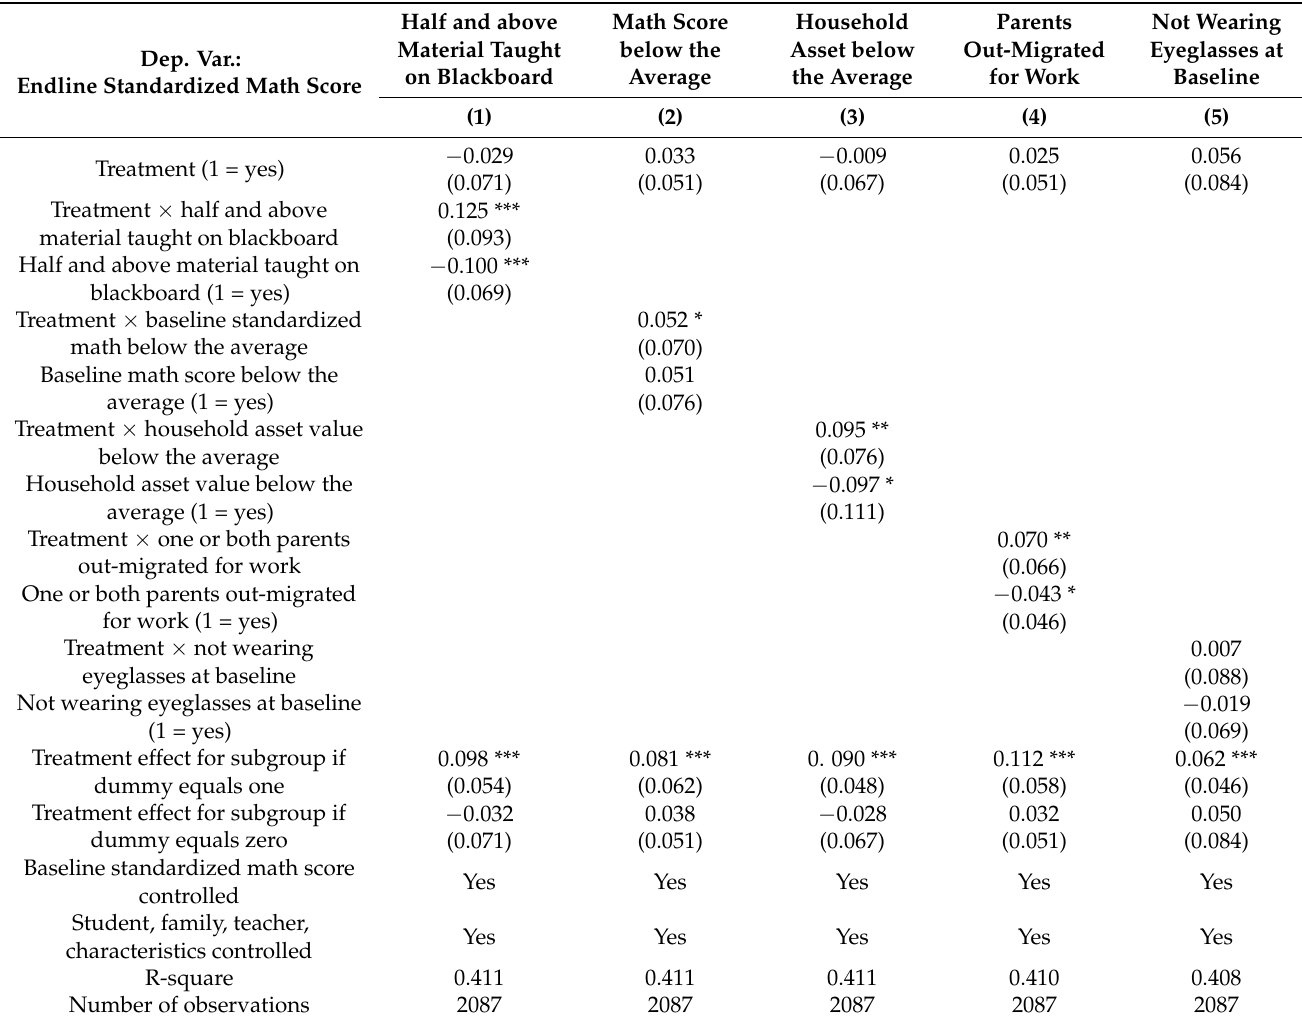
Table 7. Heterogeneity of ITT treatment effects by baseline